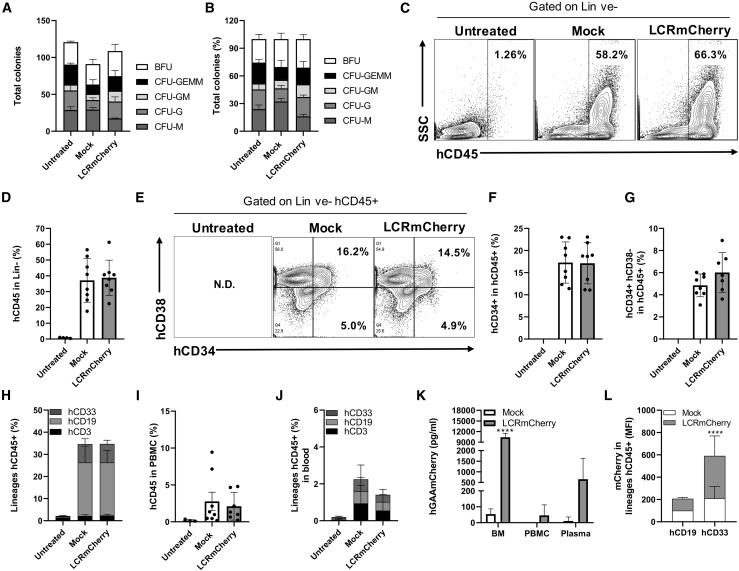
LV.LCR-EFS.GAA-Transduced hCD34+ Cells Differentiate and Engraft in NSG Mice Similarly to Mock-Transduced CellsHuman CD34+ cells were transduced with LV.LCR-EFS.hGAAmCherry (LCRmCherry) or LV.EFS.eGFP (mock) at an MOI of 100 in the presence of LentiBOOST and protamine sulfate, and then kept in culture for a CFU assay or transplanted in NSG mice. (A) Number of differentiated colonies and (B) frequency distribution of total colony counts in mock- or LCRmCherry-transduced hCD34+ cells. Untreated group refers to healthy donor hCD34+ cells left unmanipulated as control group. NSG mice were sublethally irradiated to receive transduced hCD34+ cells (0.5 × 106 cells/mouse; eight mice per group) via tail vein injection and culled 15 weeks later for analysis. Untreated refers to control NSG mice (total of four mice). (C and D) Representative fluorescence-activated cell sorting (FACS) plot of hCD45+ cells in bone marrow cells gated on live and lineage-negative (Lin-ve) cells (C) and their percentage distribution in untreated, mock, and LCRmCherry groups (D). (E–G) Representative FACS plot analysis of hCD34 hCD38 markers in bone marrow cells gated on Lin-ve hCD45+ cells (E) and the percentage distribution of hCD34+ (F) and hCD34+ hCD38− (G) cells within Lin-ve hCD45+ cells per each group. (H) Percentage of hCD3+, hCD19+, and hCD33+ cells within hCD45+ bone marrow cells. (I and J) Percentage distribution of hCD45+ cells in PBMCs (I) and percentage of hCD3+, hCD19+, and hCD33+ cells in blood (J). (K and L) hGAAmCherry expression was detected in (K) bone marrow, PBMCs, and plasma by ELISA and (L) in hCD19+ and hCD33+ hCD45+ bone marrow cells by flow cytometry. The data are shown as means ± SD. ∗∗∗∗p < 0.0001, by by two-way ANOVA test, Sidak’s multiple comparison test.